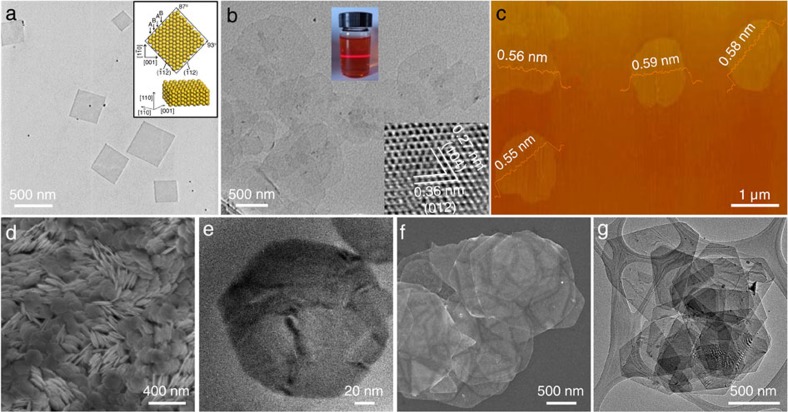
2D nanosheets synthesized using the 2D-templated synthesis method.(a) TEM images of hcp AuSSs. Inset: crystallographic models for a typical AuSS with its basal plane along the [110]h zone axis, showing ABAB stacking along the [001]h direction. Adapted from ref. 51 (b) TEM image of α-Fe2O3 nanosheets. Inset: HRTEM image and Tyndall effect of α-Fe2O3 nanosheets. Adapted, with permission, from ref. 55 (copyright 2014 American Chemical Society). (c) Atomic force microscopy (AFM) image of α-Fe2O3 nanosheets. Adapted, with permission, from ref. 55. (Copyright 2014, American Chemical Society). (d) SEM and (e) TEM images of CuInS2 nanosheets. Reproduced, with permission, from ref. 56 (© 2014 John Wiley & Sons Inc). (f) TEM and (g) SEM images of CuSe and Cu2−xSe nanosheets, respectively. Reproduced, with permission, from ref. 57 (© 2014 John Wiley & Sons Inc).